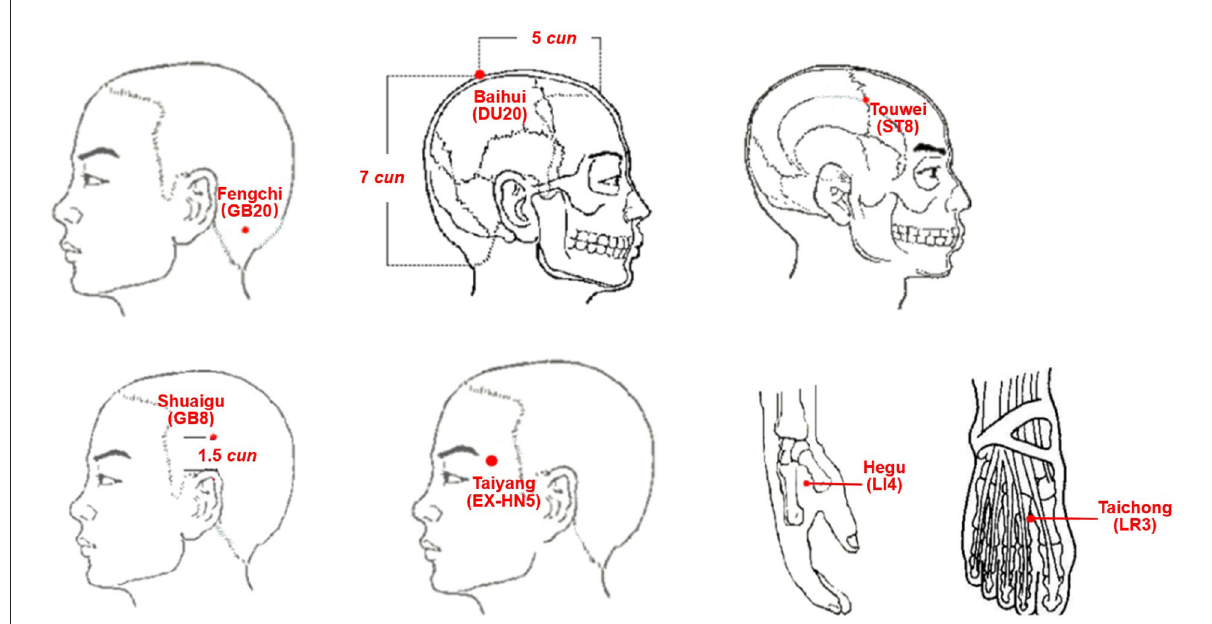
FIGURE2 Location of Acupoints . DU20 ( Baihui ): on the head, five cun directly above the midpoint of the anterior hairline or at the midpoint of the line connecting the apexes of the two auricles. GB20 ( Fengchi ): on the nape, below the occiput in the depression between the upper portion of the trapezius and sternocleidomastoid. ST8 ( Touwei ): at the lateral side of the head, within 0.5 cun of the hairline at the corner of the forehead, and 4.5 cun lateral to the median line of the head. GB8 ( Shuaigu ): on the head above the apex of the auricle and SJ-20 ( Jiaosun ), within 1.5 cun of the hairline. EX-HN5 ( Taiyang ): in the region of the temples, in the depression about one finger-width posterior to the midpoint between the lateral end of the eyebrow and outer canthus. LI4 ( Hegu ): on the dorsum of the hand, between the 1st and 2nd metacarpal bones, at the midpoint of the 2nd metacarpal bone on the radial side. LR3 ( Taichong ): on the dorsum of the foot, in the depression proximal to the first metatarsal space.